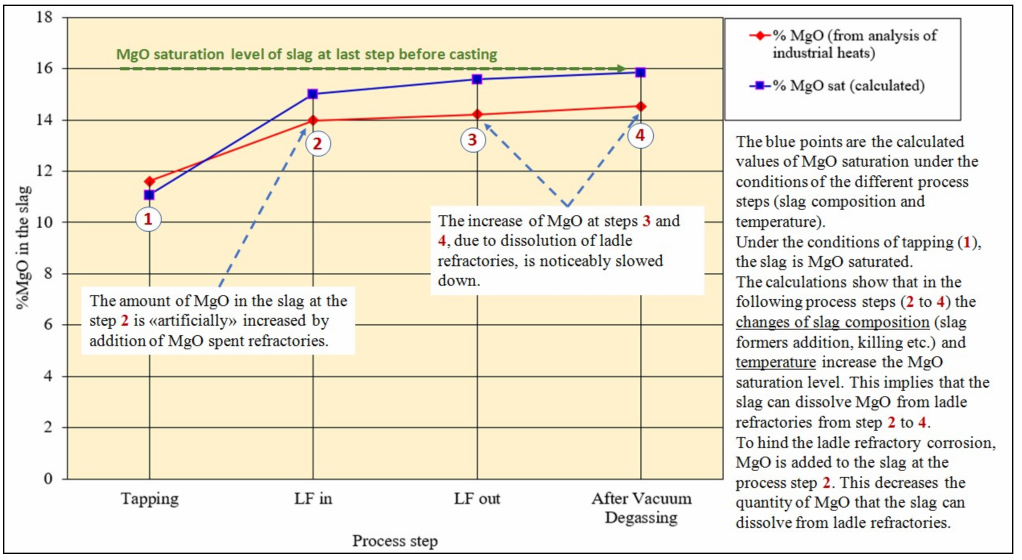
Figure 6. Use of spent refractories for slag conditioning with the aim to decrease the slag power to dissolve ladle refractories (comparison between calculated and experimental values. The experimental values have been obtained from an Italian steel